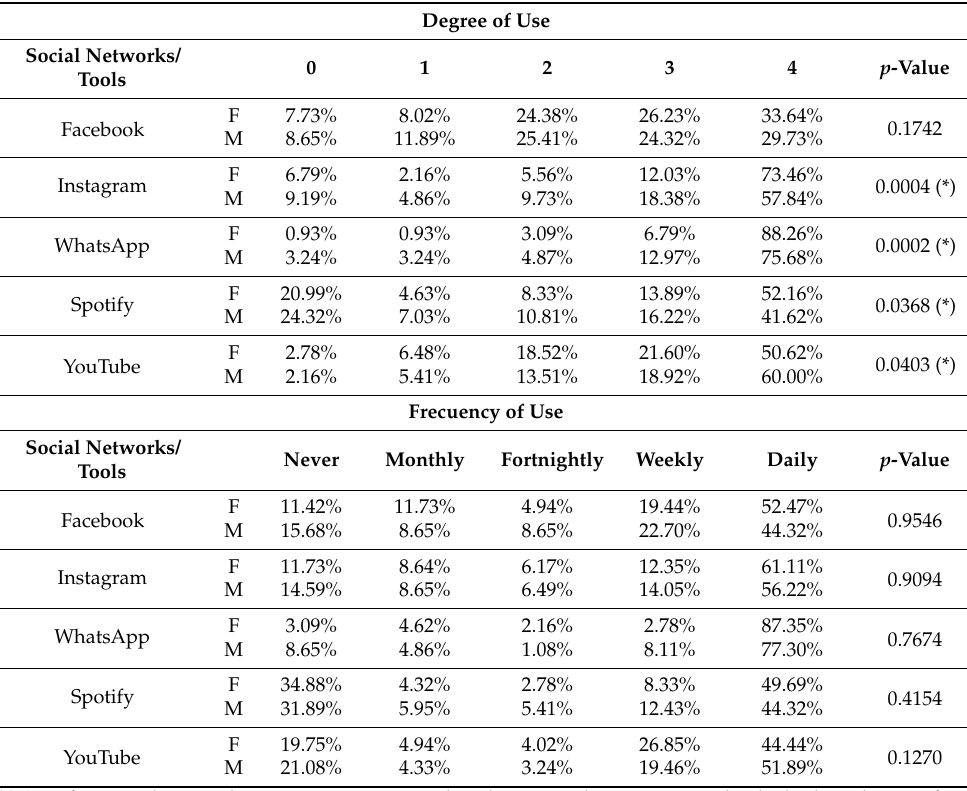
Table 10. Degree and frecuency of use of social networks and tools available on the Internet.